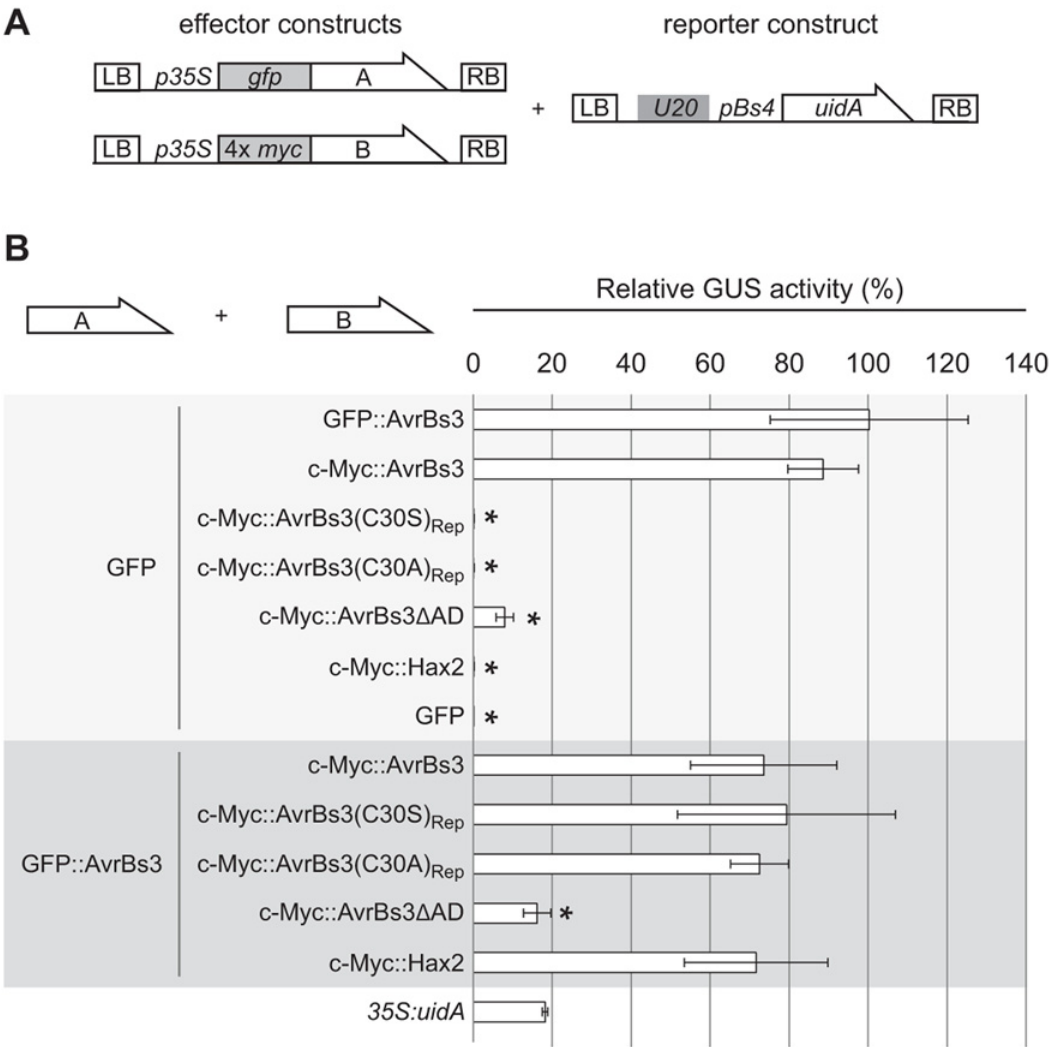
Fig 4. AvrBs3 cysteine mutants do not compete with AvrBs3 for DNA binding in planta . ( A ) T-DNA constructs used. Two different effector constructs, A and B, allow expression of (A) GFP- or (B) 4× c-Myc tagged AvrBs3 and derivatives under control of the 35S promoter. The reporter construct contains the 19-bp UPA20 UPA box in front of the tomato Bs4 minimal promoter driving a promoterless uidA reporter gene [48]. LB, left border; RB, right border. ( B ) GUS activity was determined in N . benthamiana leaves three days after Agrobacterium -mediated co-delivery of the reporter construct with the avrBs3 - or gfp construct (effector construct A) and effector construct B encoding one of the indicated proteins. Values are displayed relative to the GUS activity induced by GFP and WT AvrBs3. Error bars indicate SD. 35S : uidA served as control. Asterisks indicate statistically significant differences to the GUS activity induced by GFP and WT AvrBs3 ( t -test, P < 0.05). The experiment was repeated twice with similar